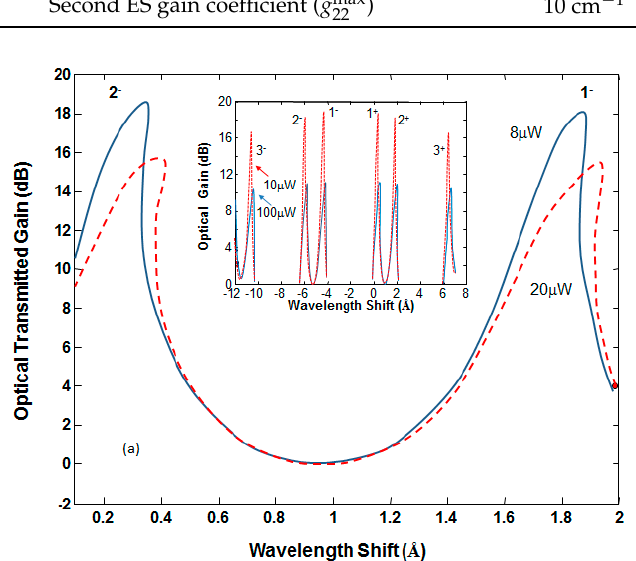
Figure 3. Optical-transmission gain as a function of wavelength shift for single-input signal. The inset shows a wider spectral range for input power equal to 8 µ W and 20 µ